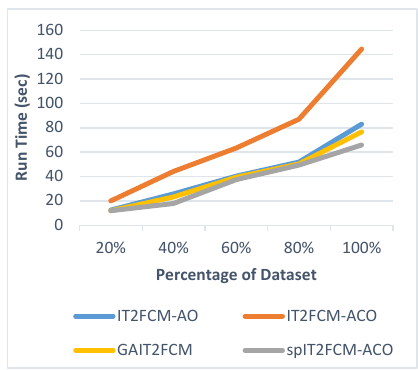
Figure 6. Analysis of run time for different percentages of airlines dataset. Sensors 2020 , 20 , x FOR PEER REVIEW